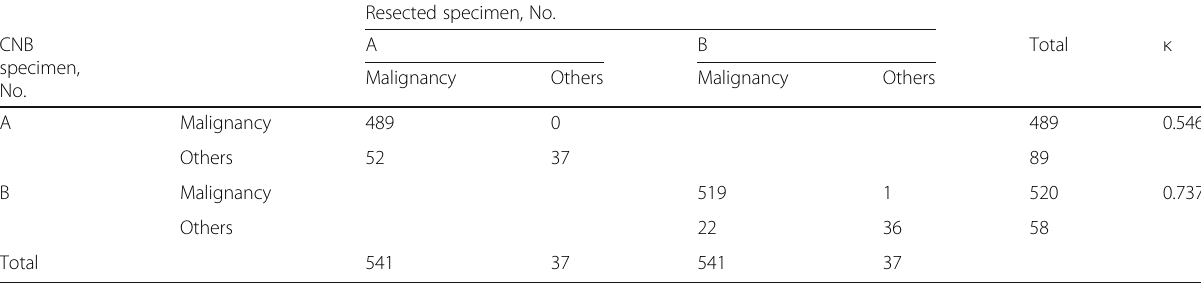
Table 3 Comparison Between the Classification of Thyroid Nodules based on CNB and Resected Specimens from Two-Classification Method Resected specimen,